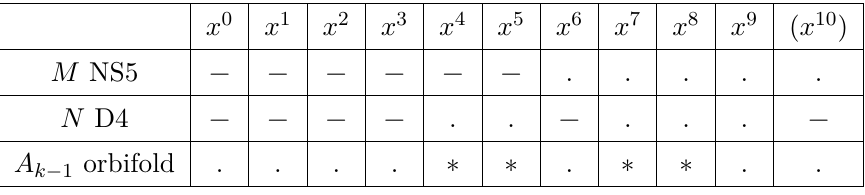
Table 1. Type IIA brane configuration for theories of Class S k .